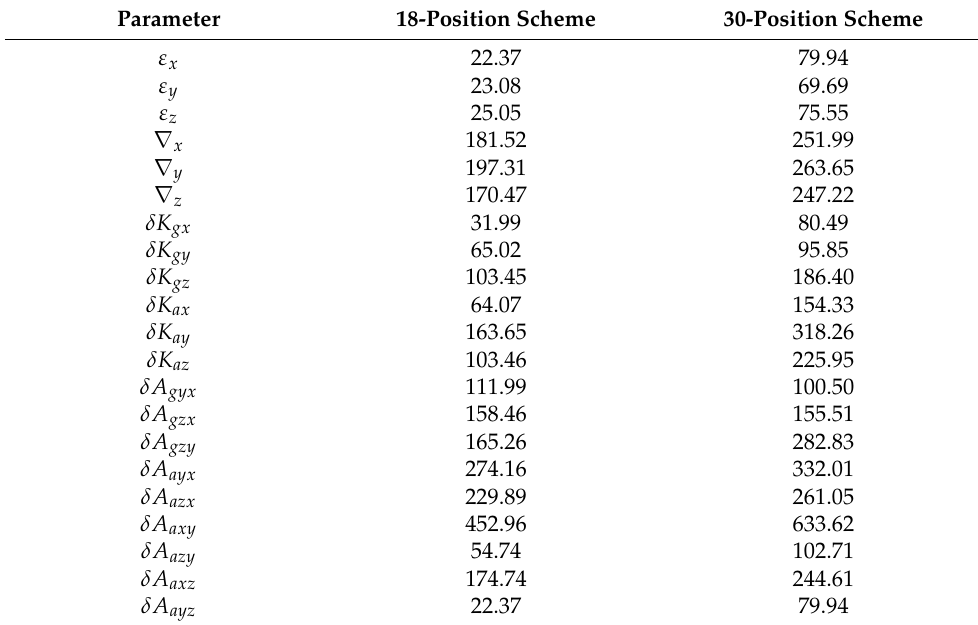
Table 2. Comparison of observability between two schemes.